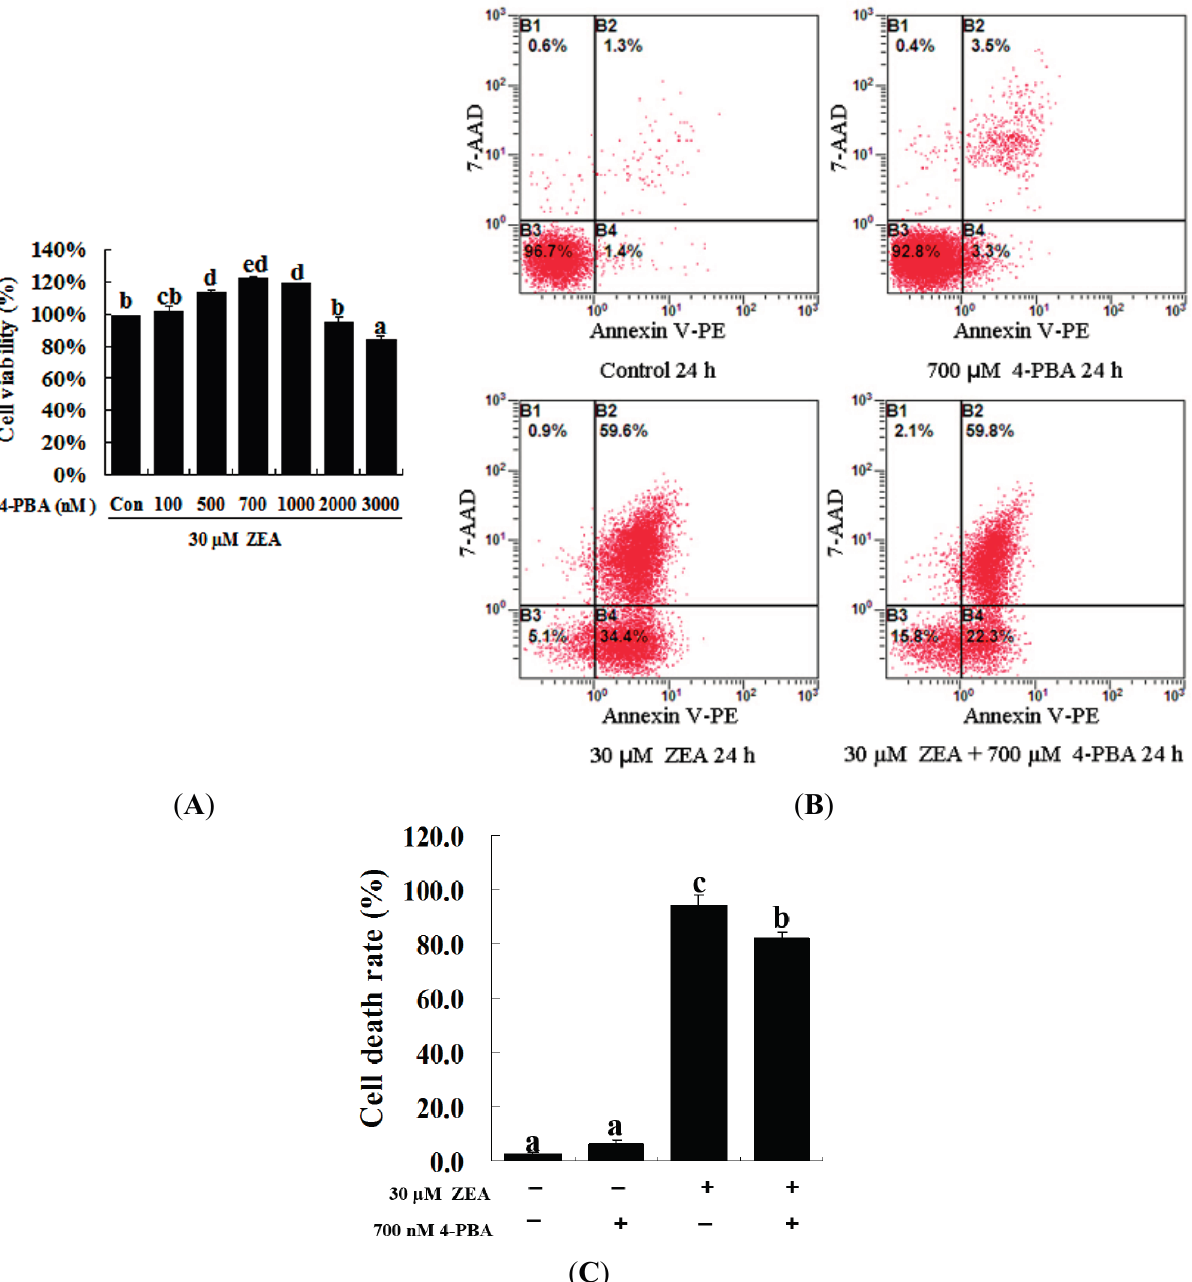
Figure 3. Effect of 4-PBA on the growth of ZEA-treated RAW 264.7 macrophages. ( A ) RAW 264.7 macrophages were treated with 30 µM ZEA in the presence or absence of 4-PBA for 24 h. Different doses of 4-PBA (0–3000 nM) were used to assess concentration effects on cell viability, and cells were then processed for the MTT assay; ( B , C ) Apoptosis analysis was detected via fl ow cytometry. After exposure to 30 µM ZEA in the presence or absence of 700 nM 4-PBA for 24 h, RAW 264.7 macrophages were collected for Annexin V-PE/7-AAD staining followed by fl ow cytometric analysis. Statistical analysis of the cell death is shown in the bar graphs. Data are presented as the mean ± SEM of three independent experiments. Bars with different letters are significantly different ( p <